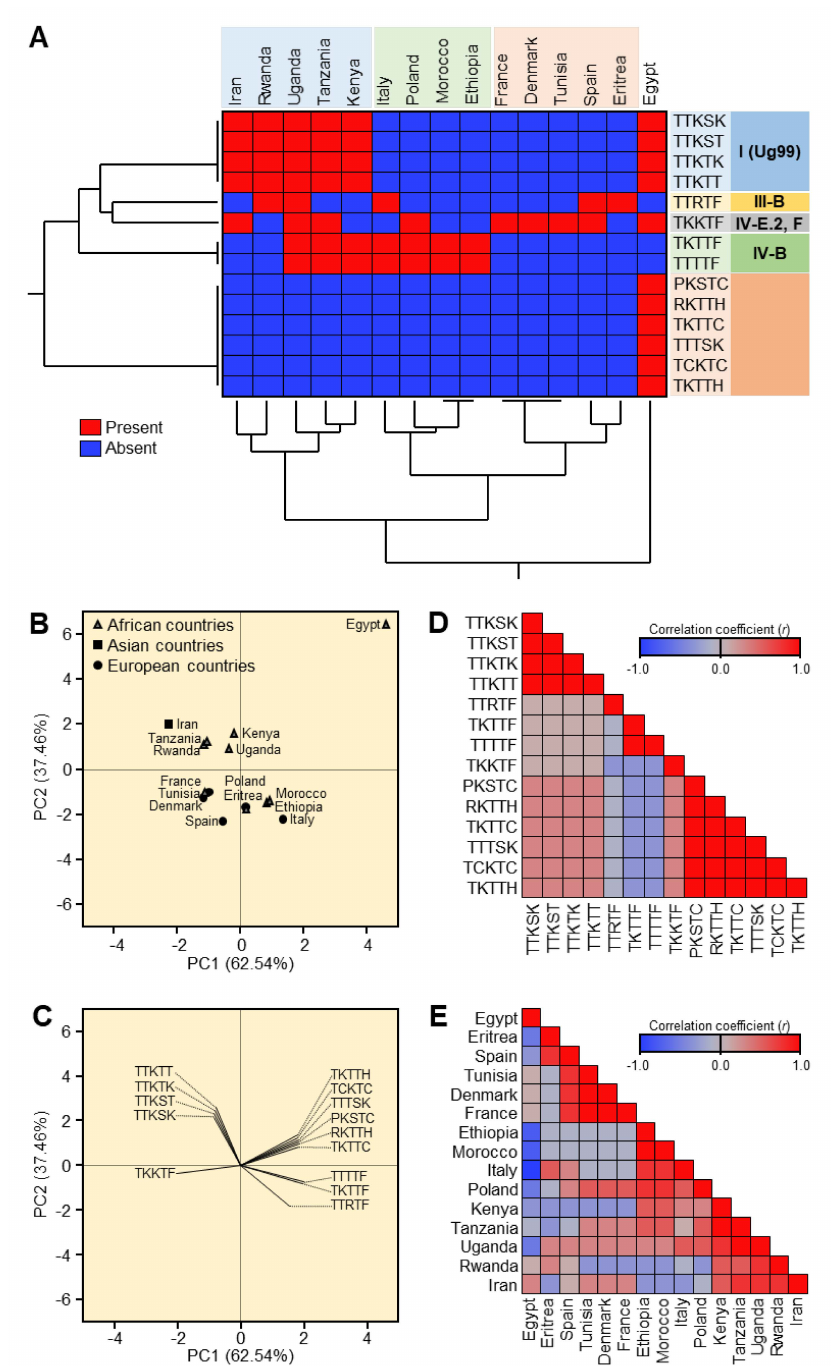
Figure 3. Two-way hierarchical cluster analysis (HCA) and Principal component analysis (PCA) of Geographical distribution of newly emerged races of Puccinia graminis f. sp. tritici in Africa, Asia, and Europe. ( A ) Two-way HCA is based on the presence/absence of the 14 races of P. graminis tritici in 15 different countries in Africa, Asia, and Europe. The heatmap diagram depicts the presence/absence of P. graminis f. sp. tritici races, with red representing the presence and blue representing the absence. Individual races are represented by rows, while locations/countries are represented by columns. PCA-related scatter plot and loading plot ( B , C ). Correlation analysis of different races and their geographical distribution ( D , E ). The heat map diagram depicts the correlation coefficient I. Positive correlation coefficienI( r ) are highlighted in red, whereas negative correlation coefficIts ( r ) are highlighted in blue (see the scale at the upper right corner of the heat